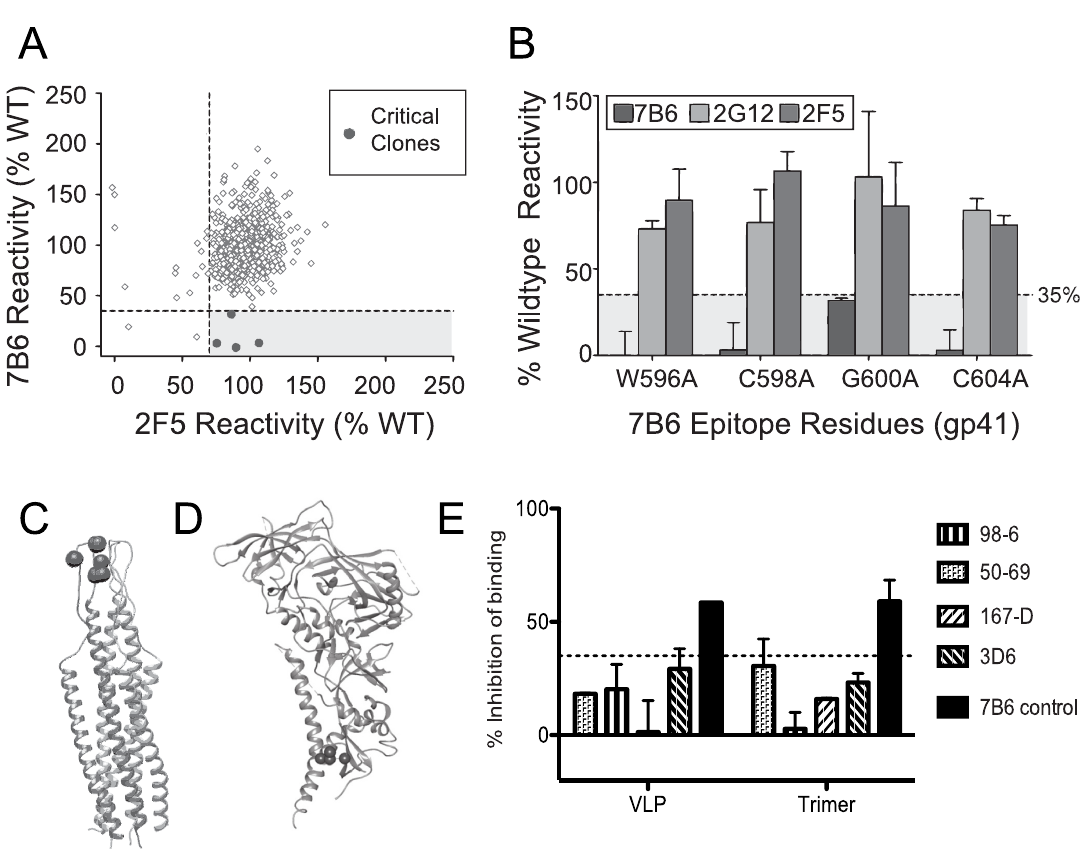
Fig 3. Identification of critical binding residues in the epitope of QtAb 7B6 by shotgun mutagenesis epitope mapping. (A) Binding of QtAb to mutant Env relative to wild-type HIV gp160 is plotted for each amino acid mutant for the test QtAb, as shown in this example of mAb 7B6 in comparison to a control mAb (2F5). Clones with reactivity < 35% for the test mAb but with > 70% reactivity for the control mAb were identified as critical for test mAb binding. (B) Alanine mutation of 4 individual residues significantly reduced 7B6 binding (dark grey bars), but did not impair binding of control Abs (2G12 or 2F5, shown in light grey or mid grey). Bars represent the mean and range of two replicates. (C) Structural analysis of the critical residues required for 7B6 binding. Critical residues are shown on one chain of the gp41 post-fusion trimer (PDB 2EZQ) and (D) the BG505 SOSIP.664 HIV-1 Env trimer (PDB 4ZMJ). (E) Biotinylated competition Ab 7B6 was competed against known gp41 mAbs, including Cluster I mAb 3D6 (thick diagonal). The experiment contained duplicate wells and was repeated twice. Competition of > 40% inhibition of binding of the BCA, approximately twice the background % of controls (over hatched line), was considered a positive result and only shown with the control 7B6 unlabeled Ab (filled